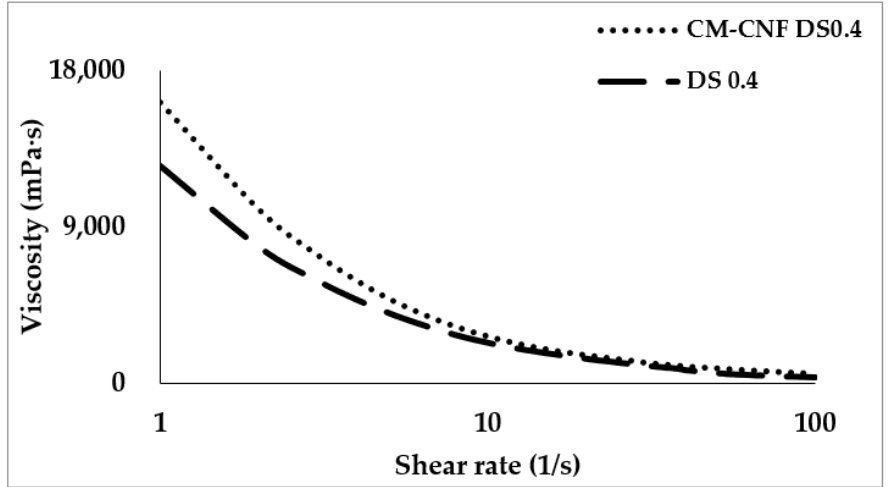
Figure 5. Viscosity from green tea waste DS 0.4 and CM CNF DS 0.4. Similar to what was observed for viscosity, adding carboxyl groups increases the storage and loss modulus of the CNF GTW gels (Figure 6a – c). The effect of ionic strength on the storage and loss modulus of 2% CNF GTW caused by adding MCA is shown in Figure 6b,c. The G′ value increased from 202.51 to 228.85 Pa as the concen tration increased from 2.17 to 2.89 g MCA, confirming that a stronger network of CNF gel is created at 2.89 g MCA. Meanwhile, CNF GTW DS 0 (Figure 6a) without added MCA has a really low storage and loss modulus.